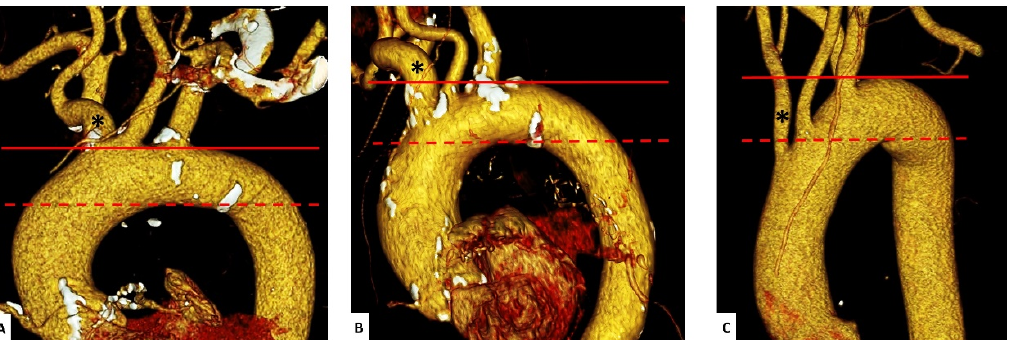
Figure 3. Types of the aortic arch. Pre-TAVI CTA in Volume Rendering Technique (VRT) for evaluation of the aortic arch. The types were defined as I (origin of the brachiocephalic artery at the height of the maximum cranial curvature of the aortic arch; ( A ), Type II (origin between the maximum cranial and caudal curvature; ( B ) and Type III (origin below the caudal curvature; ( C ). The maximum cranial (—–) and maximum caudal (-) curvature of the aortic arch as well as the brachiocephalic artery (*) are delineated.